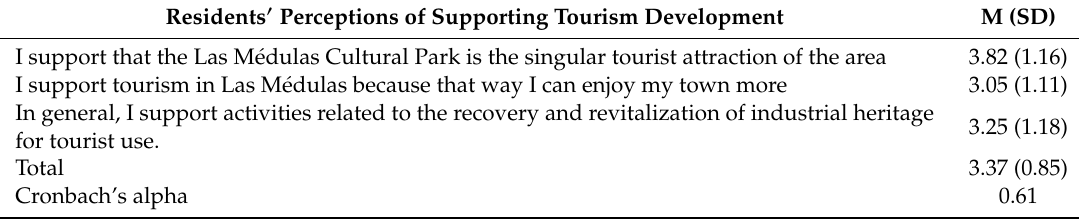
Table 5. Descriptive analysis of tourism support Source: Author´s own.